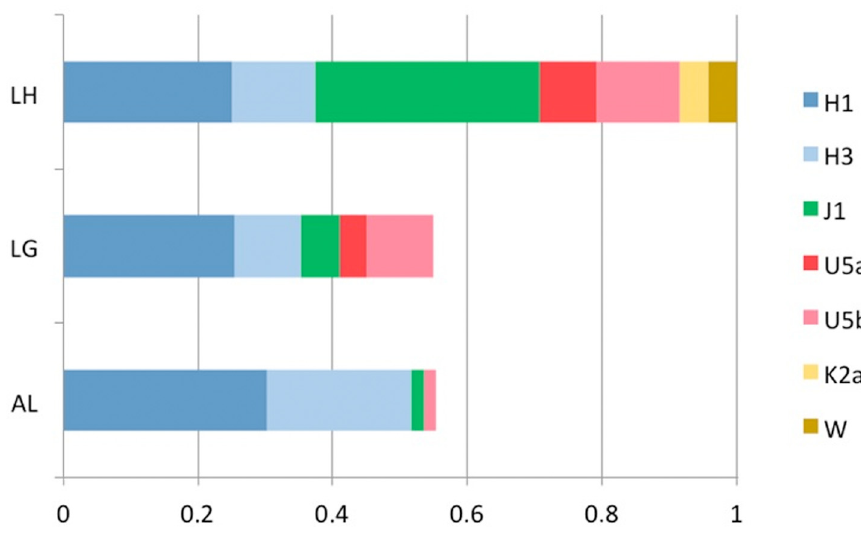
Fig 5. mtDNA haplogroups observed in La Hoya (LH), and their frequencies in the present-day populations studied herein (LG: Laguardia; AL: Alava).